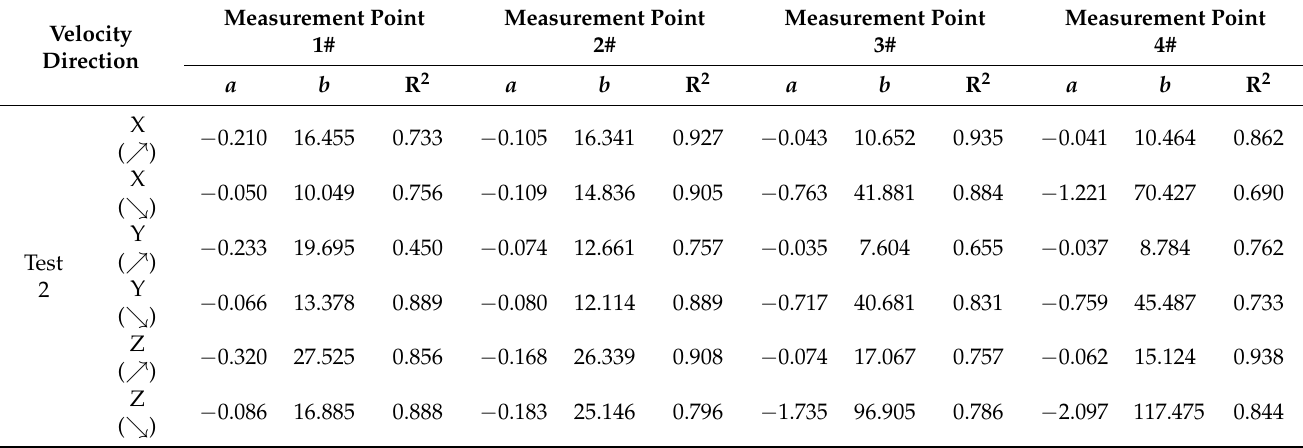
− images are drawn. Figure 10